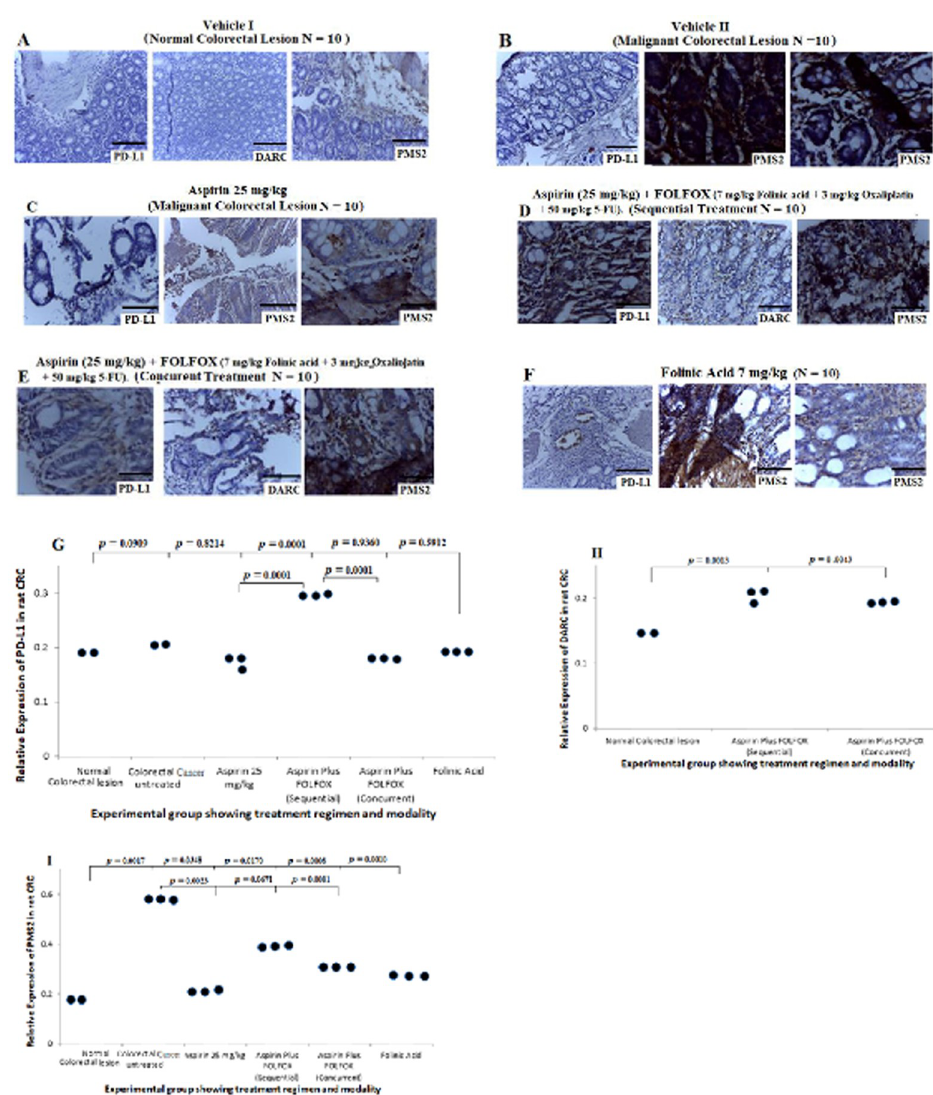
Fig 9. Prognostic significance of PD-L1, DARC and DNA mismatch repair protein PMS2 in NMU-induced CRC in rat and treated with aspirin, and aspirin plus FOLOFOX in varous combinations (scale bar = 50 μ m for H&E and scale bar = 100 μ m for IHC). A) Show negative expression of PD-L1, DARC and PMS2 in sections from non CRC-bearing rats. B) Show strong positive expression of PMS2 and negative expression of PD-L1 in the sections from the untreated CRC-bearing rats. C) CRC sections from the rat treated with 25 mg/kg aspirin showing negative expression of PD-L1 and mild expression of PMS2. D) Sections from aspirin plus FOLFOX sequential treated cells showing strongly positive expression of PD-L1 and PMS2 with mild expression of DARC. E) CRC sections treated with concurrent dose of aspirin plus FOLFOX showing mild expression of PD-L1 and DARC and strongly positive expression of PMS2. F) Sections treated with folinic acid showing focal expression of PD-L1, strong positive expression of DARC and mild expression of PMS2. G to I) Quantitative analysis of the PD-L1, DARC and PMS2 from the study showing expression pattern typified in dot plot post and pre-treatment with aspirin and aspirin plus FOLFOX in various combinations. and aspirin plus FOLFOX concurrently ( p = 0.0081; Fig 9I). However, there was no significant difference in PMS2 expression from the untreated CRC sections compared with aspirin plus FOLFOX sequential treatment ( p = 0.0671). These data suggest that, sequential combination